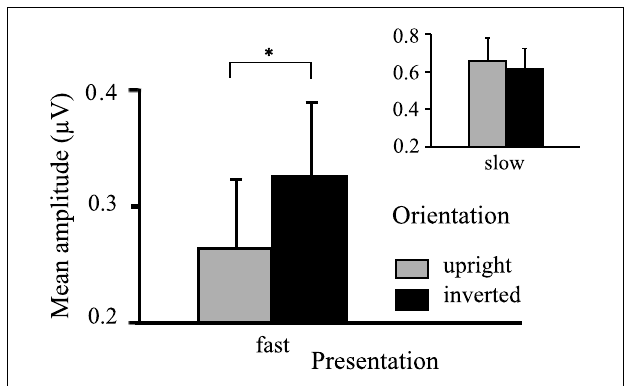
FIGURE 5 | Graph displaying interaction effect of presentation rate. Faster frequencies in both experiments (i.e., 15, 20Hz) show overall increased ssVEP amplitude for inverted faces, whereas slower frequencies in both experiments (i.e., 5, 10Hz) do not show this. Error bars indicate SEMs for ssVEP amplitudes.